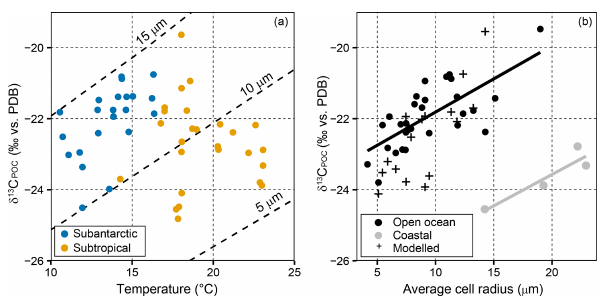
Figure 6. δ 13 C POC variability and model predictions with temper- ature and cell size. (a) δ 13 C POC vs. temperature, with the modelled estimates for cell radii of 5, 10 and 15µm. Blue circles refer to SASW, and orange circles refer to subtropical waters. (b) δ 13 C POC vs. cell radius as derived from pigment data. Samples from the east- ern and western margin are excluded from correlation estimates. Rio de la Plata: r = 0 . 92, df = 2, p = 0 . 075; open ocean: r = 0 . 72, df = 30, p< 0 . 001. Modelled δ 13 C POC is estimated using measured temperature and cell size and an assumed constant cell growth rate of 1.1d − 1 . Black crosses in show modelled results. The average cell radius is calculated from microplankton (25µm), nanoplankton (2.5µm) and picoplankton (0.5µm). There are fewer data points in (b) , as we did not have corresponding cell size data for all of the δ 13 C POC